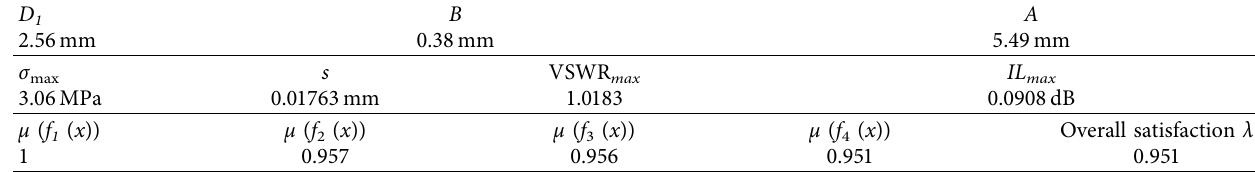
Table 3: Optimized structural parameters and the satisfaction of each objective parameter.